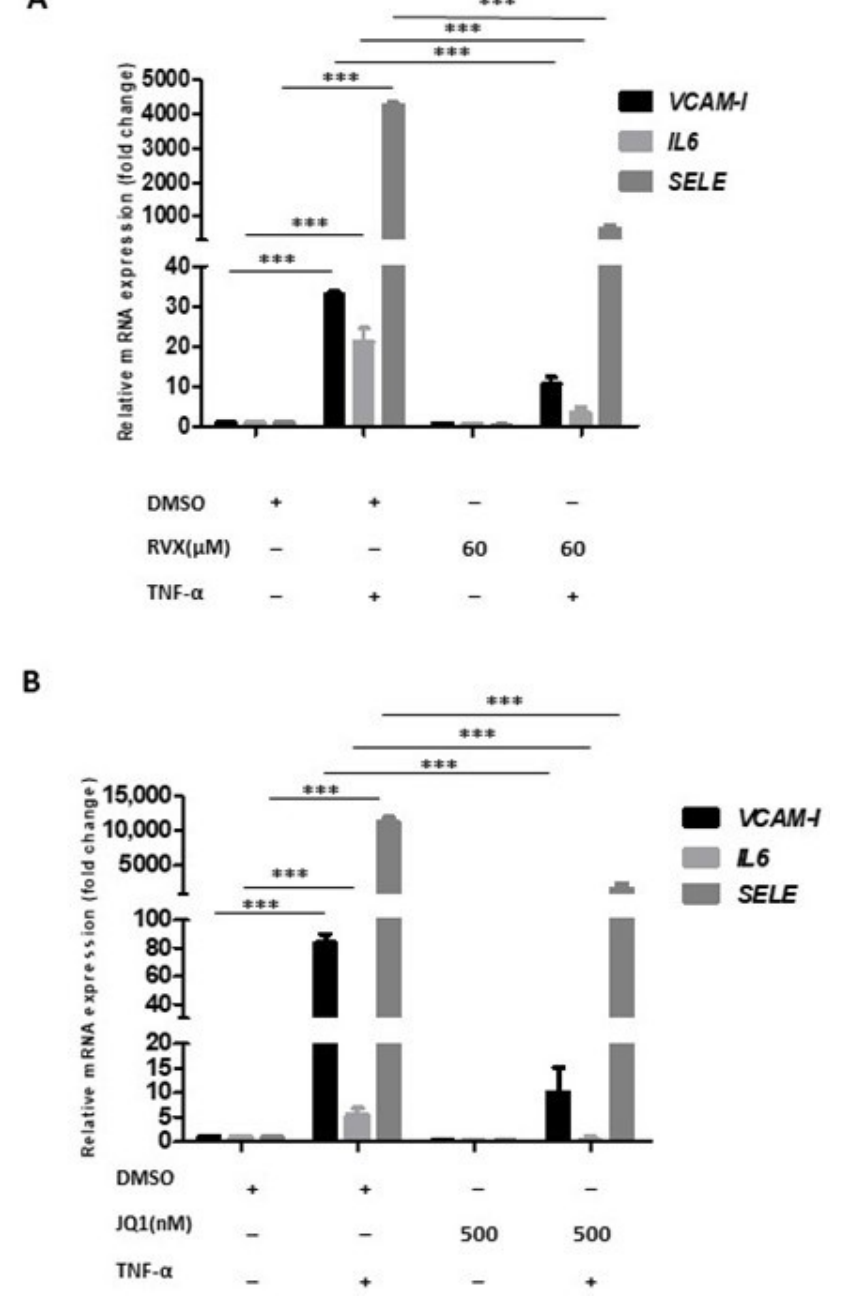
Figure 4. BRD4 inhibition using RVX208 and JQ1. ( A ). bar graph showing relative mRNA levels of inflammatory markers VCAM ‐ I, IL6, and SELE, in HUVECs treated with DMSO, TNF ‐α‐ only, RVX208 ‐ only, and RVX208 ‐ TNF ‐α ( B ). Bar graph showing relative mRNA levels of inflammatory markers VCAM ‐ I, IL6, and SELE, in HUVECs treated with DMSO, TNF ‐α‐ only, JQ1 ‐ only and JQ1 + TNF ‐α . One ‐ way ANOVA with Tukey’s post ‐ test used. Data are shown after normalization to housekeeping gene GAPDH. Values are mean ± SD of three biological replicates (*** = p < 0.001). Interestingly, we also observed that both BRD4 inhibitors repressed basal expression (without TNF ‐α stimulation) of VCAM ‐ 1 and IL6 compared to DMSO solvent control. RVX208 treatment reduced basal expression levels of SELE, VCAM ‐ I, and IL6 by 3.7 ‐ , 1.4 ‐ and 2 ‐ fold, respectively. Similarly, JQ1 reduced basal expression levels of SELE, VCAM ‐ I, and IL6 by 7.14 ‐ , 3 ‐ , and 5 ‐ fold, respectively (Supplementary Figure S2).